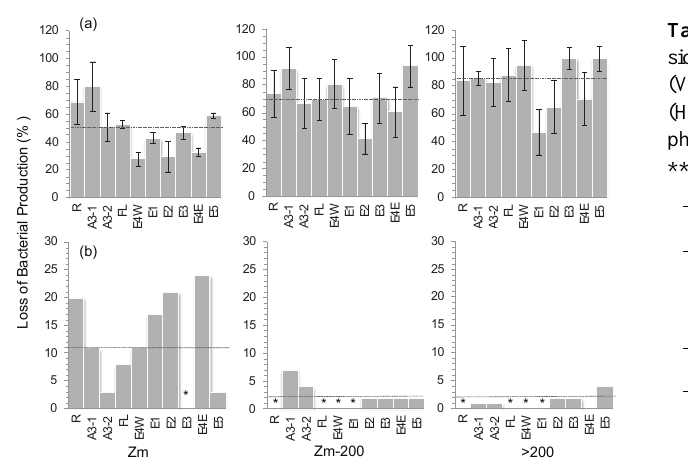
Figure 5. Heterotrophic nanoflagellate (a) and virus (b) mediated mortality of bacteria, as a percentage of bacterial production mea- sured in the mixed layer (ML), from the bottom of the mixed layer to 200m ( Z ML –200m), and between 200 and 1000m (>200m). The vertical line denotes the median value for each layer. Error bars in (a) indicate the standard deviation of the mean values of each layer. No error bars in (b) since the values are issue of TEM obser- vations of the pooled samples in each layer (see also methods). *: undetectable, the % FVIC was <0.4 resulting in negative values of %FIC (Eq. 1).